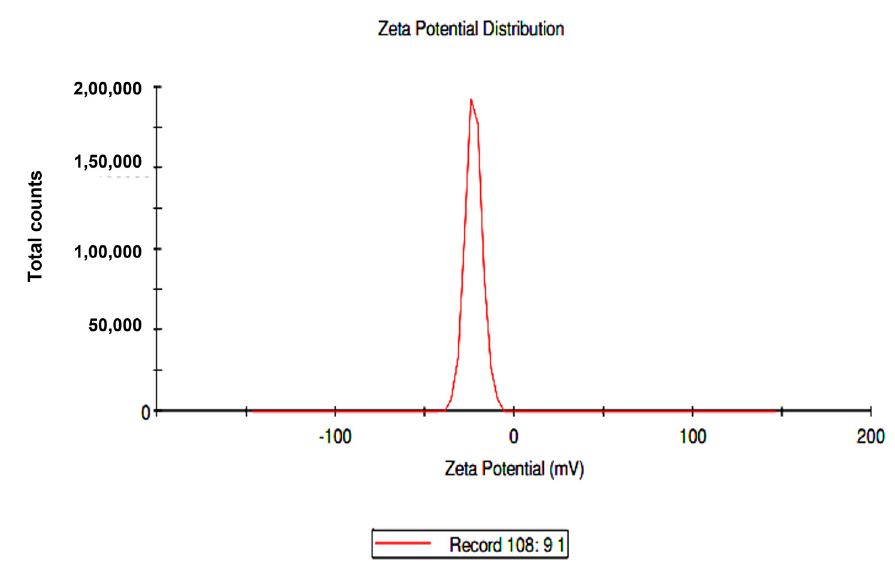
Figure 6. Zeta Potential analysis for the synthesized silver nanoparticles.